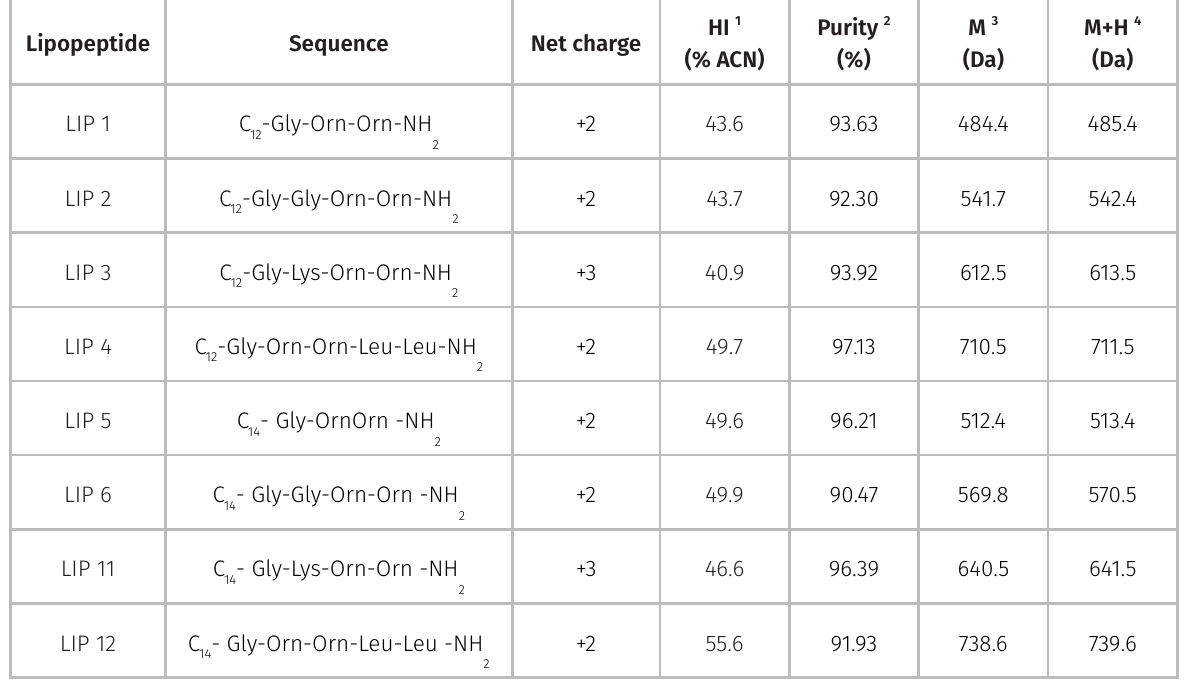
Table I. Sequence and physicochemical characterization of designed and synthesized short lipopetides.